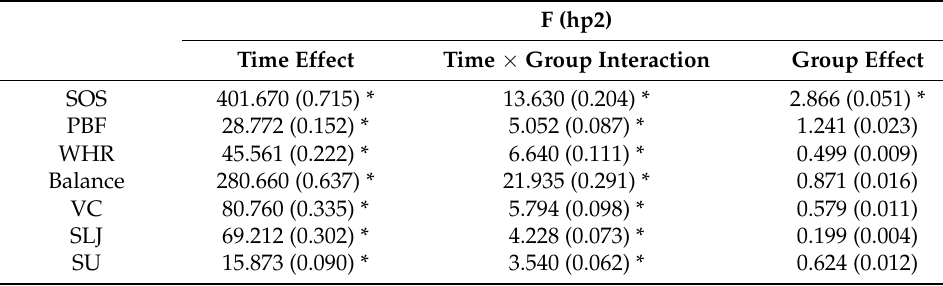
Table 2. The changes between and within